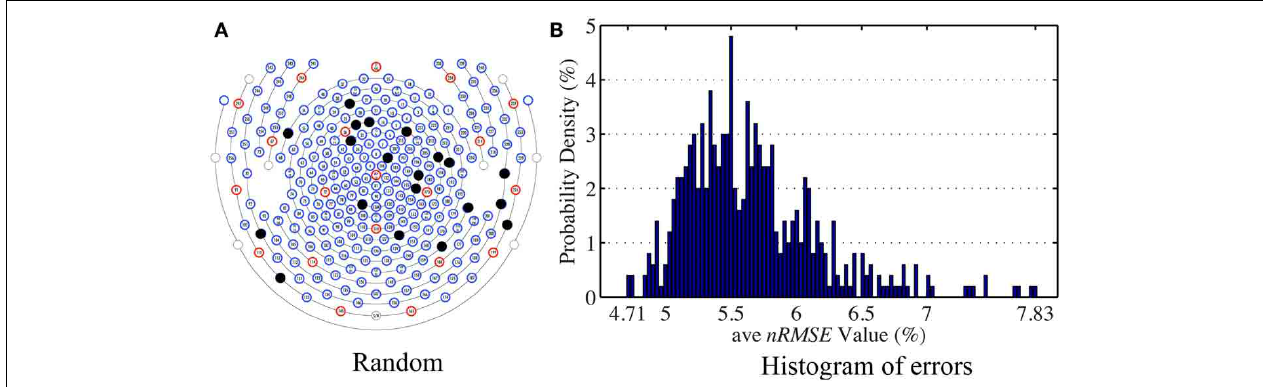
FIGURE 10 | (A) One of the patterns selected with random permutation. (B) Histogram of the estimation errors ( ave nRMSE ) from 500 realizations of random patterns. The highest error is 7.83% when the lowest error is 4.71%.